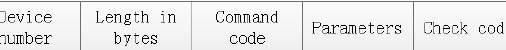
Fig. 2. Communication protocol message format for the GYCOM anode power supply.